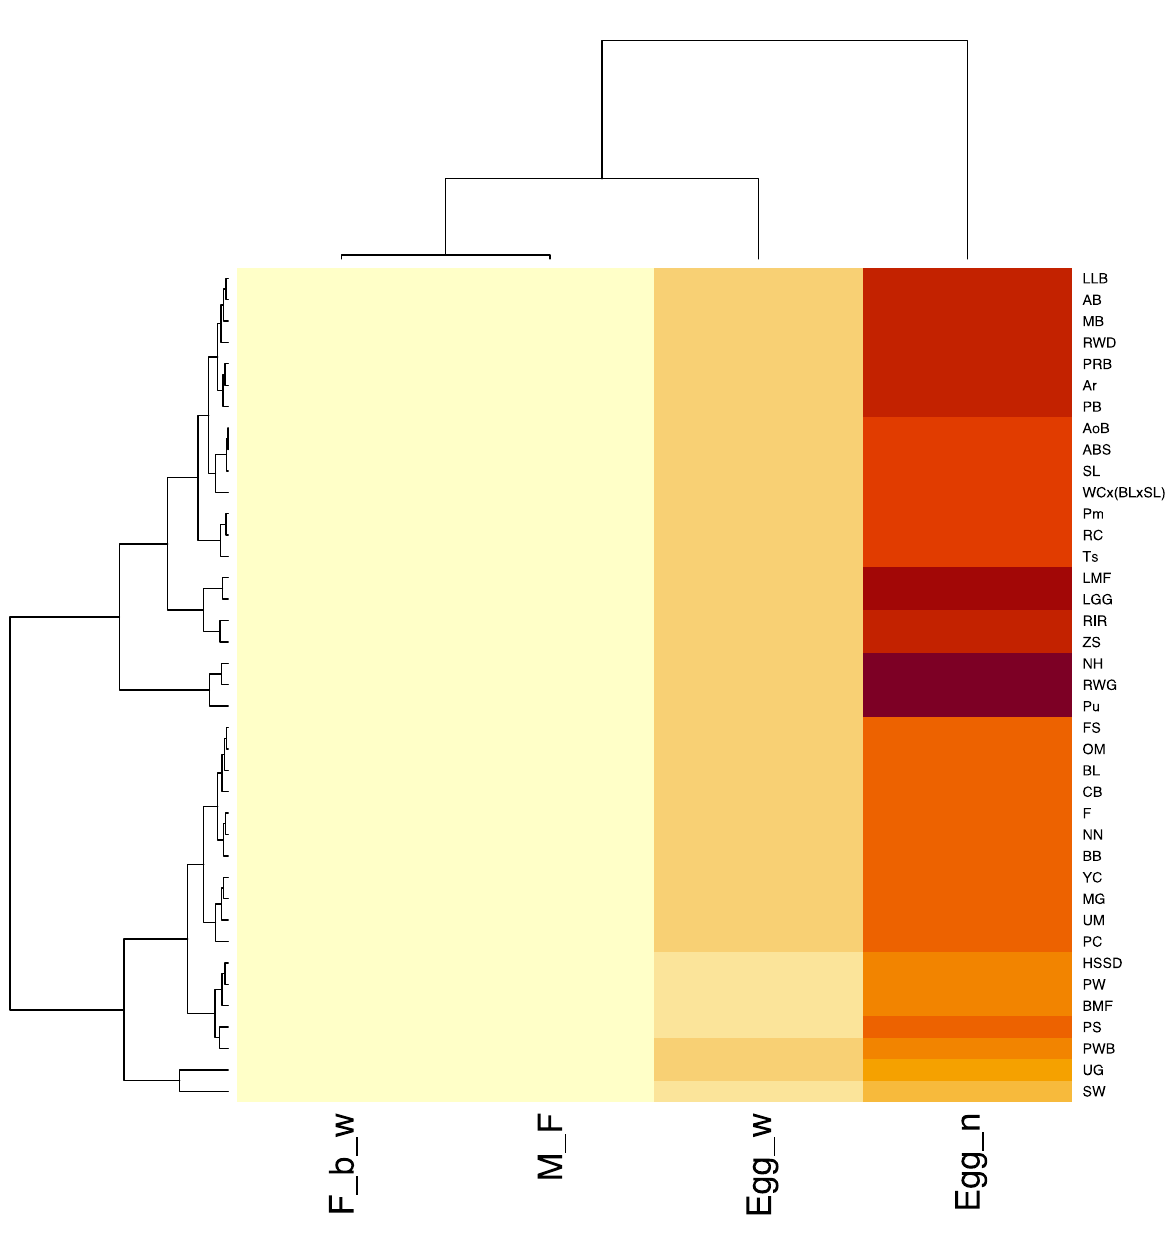
Figure 2. A heatmap showing distribution of the 39 phenotyped chicken breeds/populations and built using the heatmap function in stats package (R v. 4.2) on the base of the following phenotypic traits: female body weight (F_b_w), a sum of male and female body weights (M_F), egg weight (Egg_w), and 52-week egg number (Egg_N). The rows (populations) and columns (traits) are ordered in accordance with hierarchical clustering as displayed through the respective dendrograms. Lighter colors correspond to lower correlation, and darker ones to higher correlation. Population codes are given according to Supplementary Table S1.